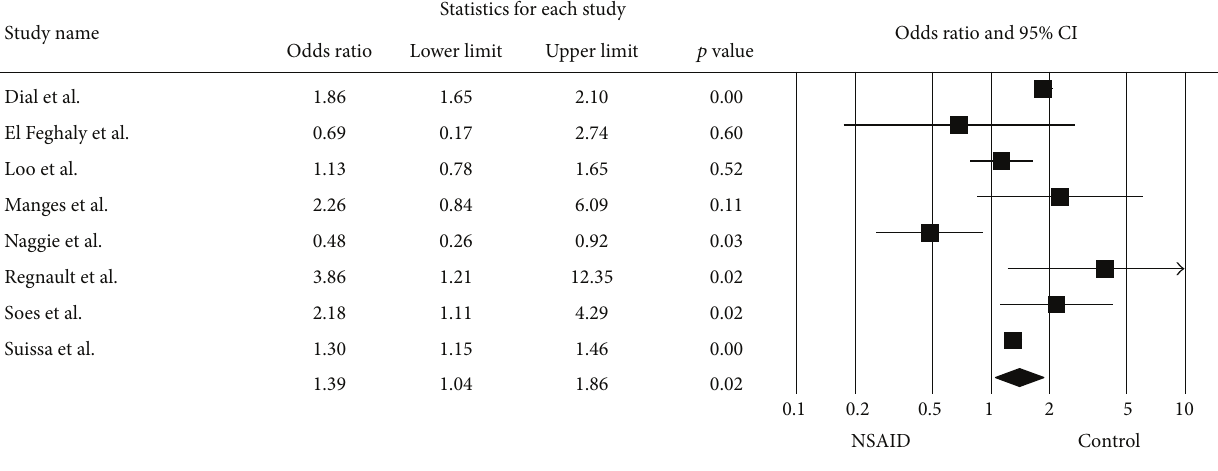
Figure 2: Forest plot of the included studies comparing odds ratio of CDAD in patients who used NSAID and those who did